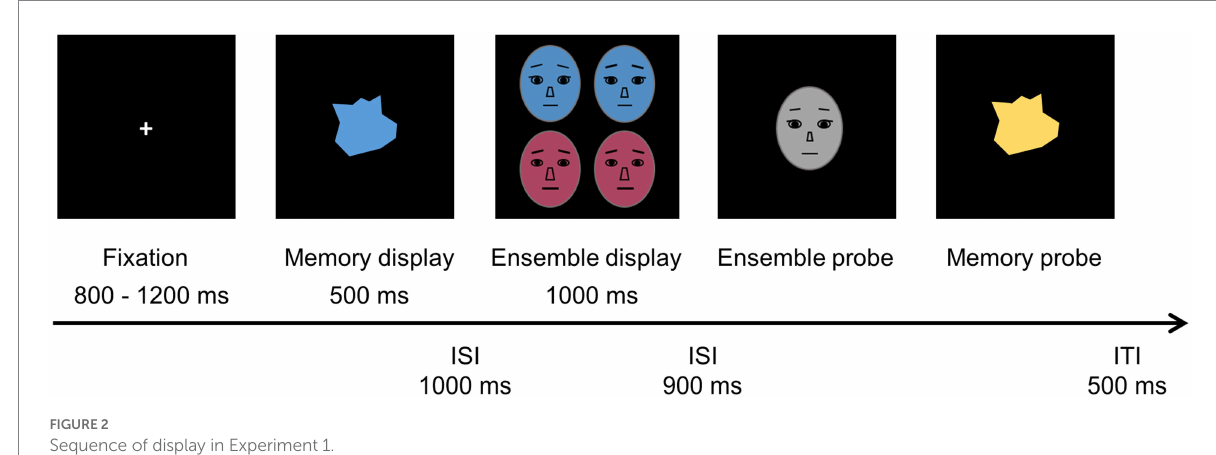
FIGURE 2 Sequence of display in Experiment